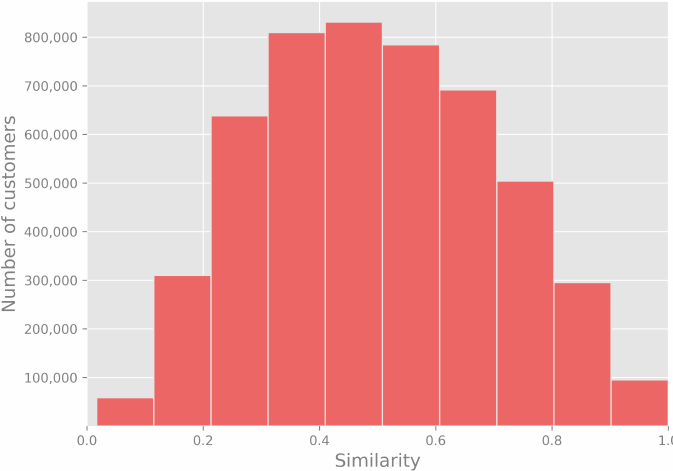
Figure 3. Histogram of scaled cosine similarity for the dataset of individual